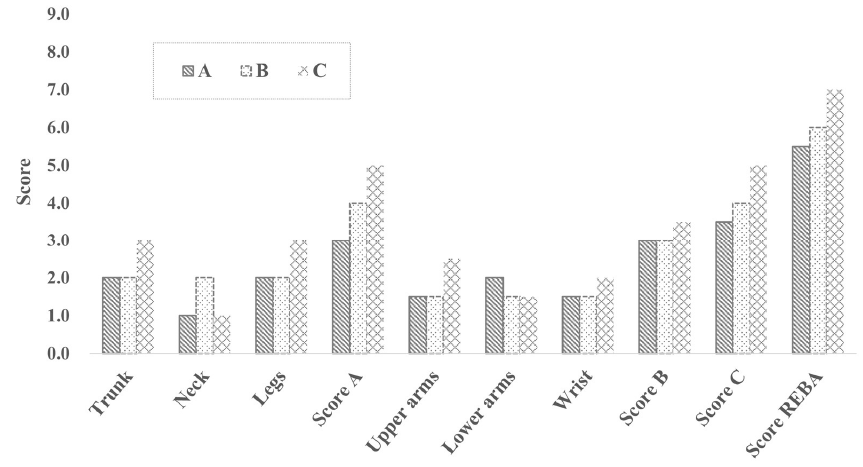
Figure 21. Precision evaluation results of cutter working posture.